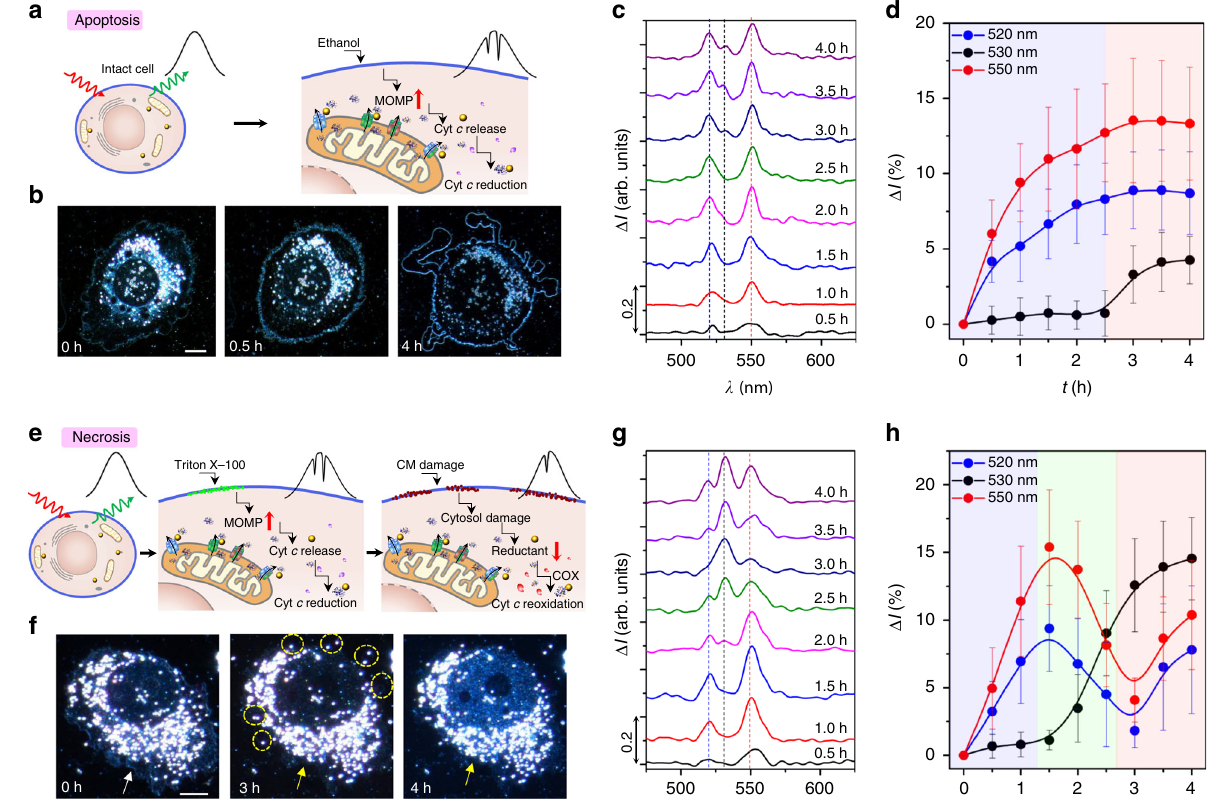
Fig. 4 Real-time intracellular QBET imaging of ET during cellular apoptosis and necrosis. a – d , Non-invasive QBET imaging for cell apoptosis. a Schematic of cellular stimulus with ethanol for apoptosis. Major QBET signals for Cyt c (red.) are captured during apoptosis. MOMP: mitochondrial outer membrane permeabilisation. b Dark- fi eld images of the cell at different time with the stimulus of ethanol, scale bar: 10 μ m. t = 0 h, the beginning of apoptosis measurement. t = 0.5 h, cell shrinkage was observed. t = 4 h, nucleus was ruptured and apoptosis bodies was formed. c Scattering spectra difference showing QBET in A/B/C tunnel junction in the process of cell apoptosis, data obtained from region VIII in Supplementary Fig. 9. The QBET spectra differences were obtained by subtracting the spectra at different measuring times from the spectra at the beginning of the measurement ( t = 0 h). d Quantised dips at 520, 530 and 550 nm in the process of cell apoptosis. e – h QBET imaging with triton X-100 stimulus for cell necrosis. e Schematic of cellular stimulus with triton X-100 for necrosis. QBET is captured from Cyt c (red.) to Cyt c (Ox.) during necrosis. CM: cell membrane, COX: Cyt c oxidase. f Dark- fi eld images of the cell with the stimulus of triton X-100. t = 0 h, white arrow indicates the intact cell membrane; t = 3 h, yellow arrow indicates partial lysis of cell membrane, yellow circles indicate organelles are released out to extracellular environment; t = 4 h, yellow arrow indicates the damage and lysis of the whole membrane. Scale bar: 10 μ m. g Scattering spectra difference showing QBET in the process of cell necrosis, data obtained from GNP in region I in Supplementary Fig. 14. The dip changes show the change from Cyt c (Red.) to Cyt c (Ox.), and fi nally both Cyt c (Red.) and Cyt c (Ox.). h , Quantised dips at 520, 530, and 550 nm in the process of cell necrosis with cyclic behaviour. The curves in d , h are cubic B-spline connection of the experimental data (Supplementary Note 6). The cartoons for Cyt c molecules in a , e were created from the RSCB protein data bank 54 . Error bars